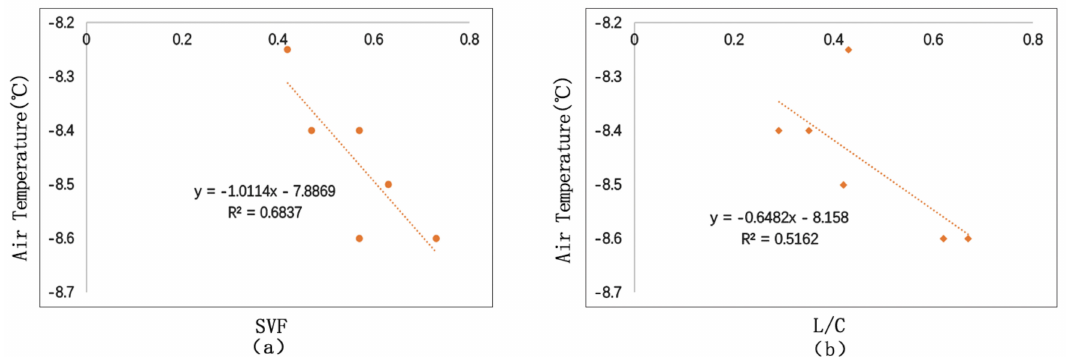
Figure 20. Correlation between SVF, L / C, and temperature: ( a ) correlation between SVF and Ta; ( b ) correlation between L / C and